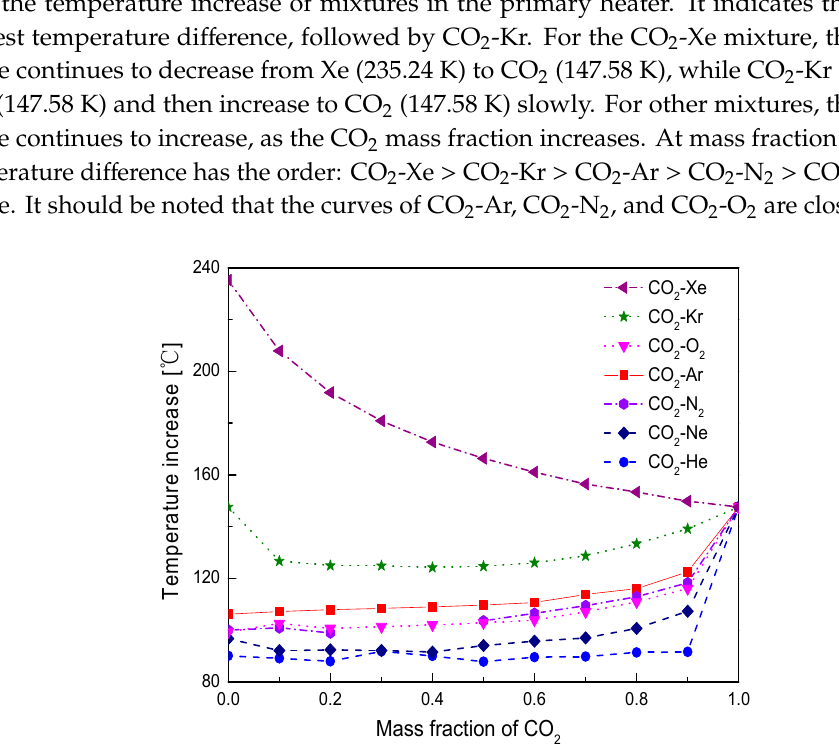
Figure 10. Low cycle pressure of mixtures at different mass fractions of CO 2 .